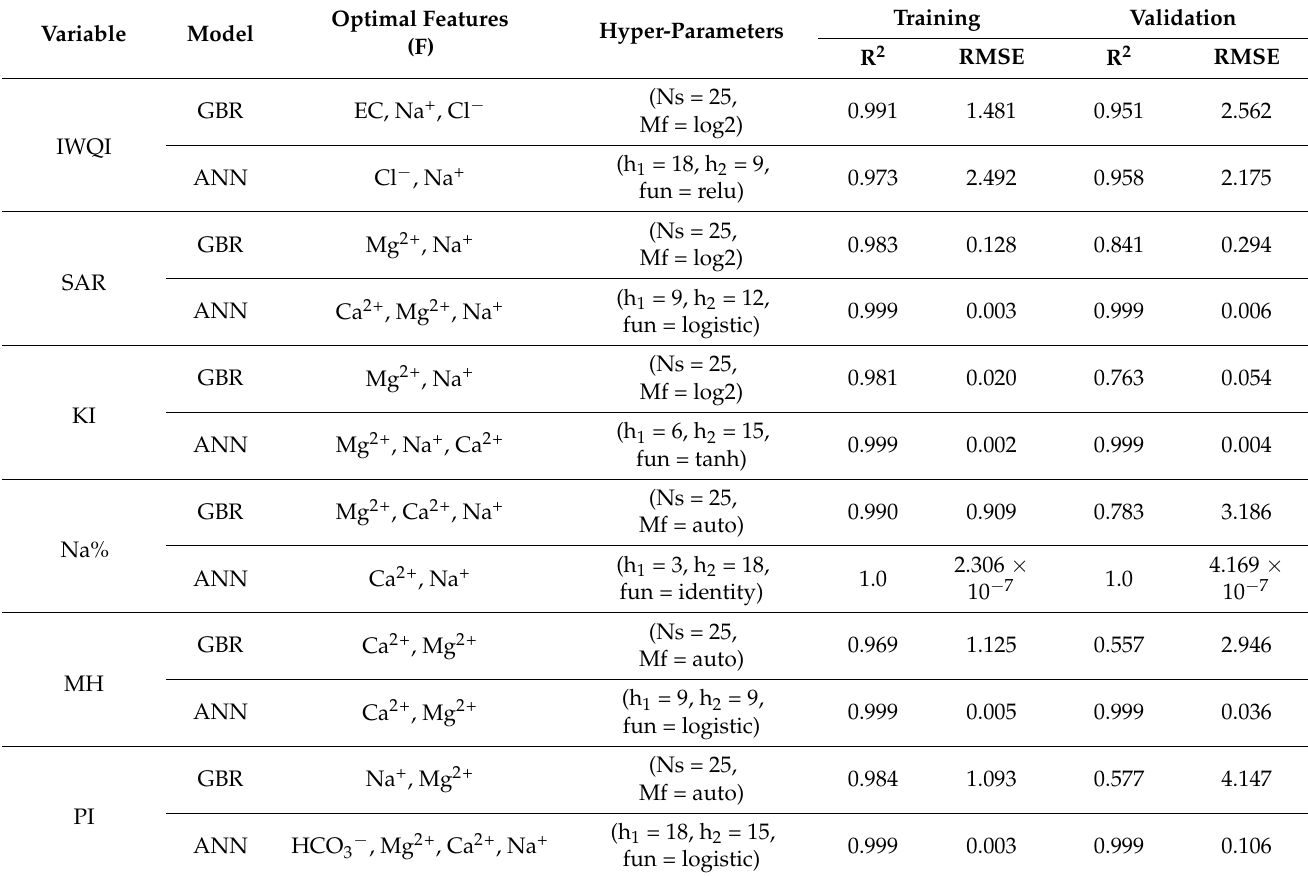
Table 5. The outcomes of GBR and ANN models based on optimal